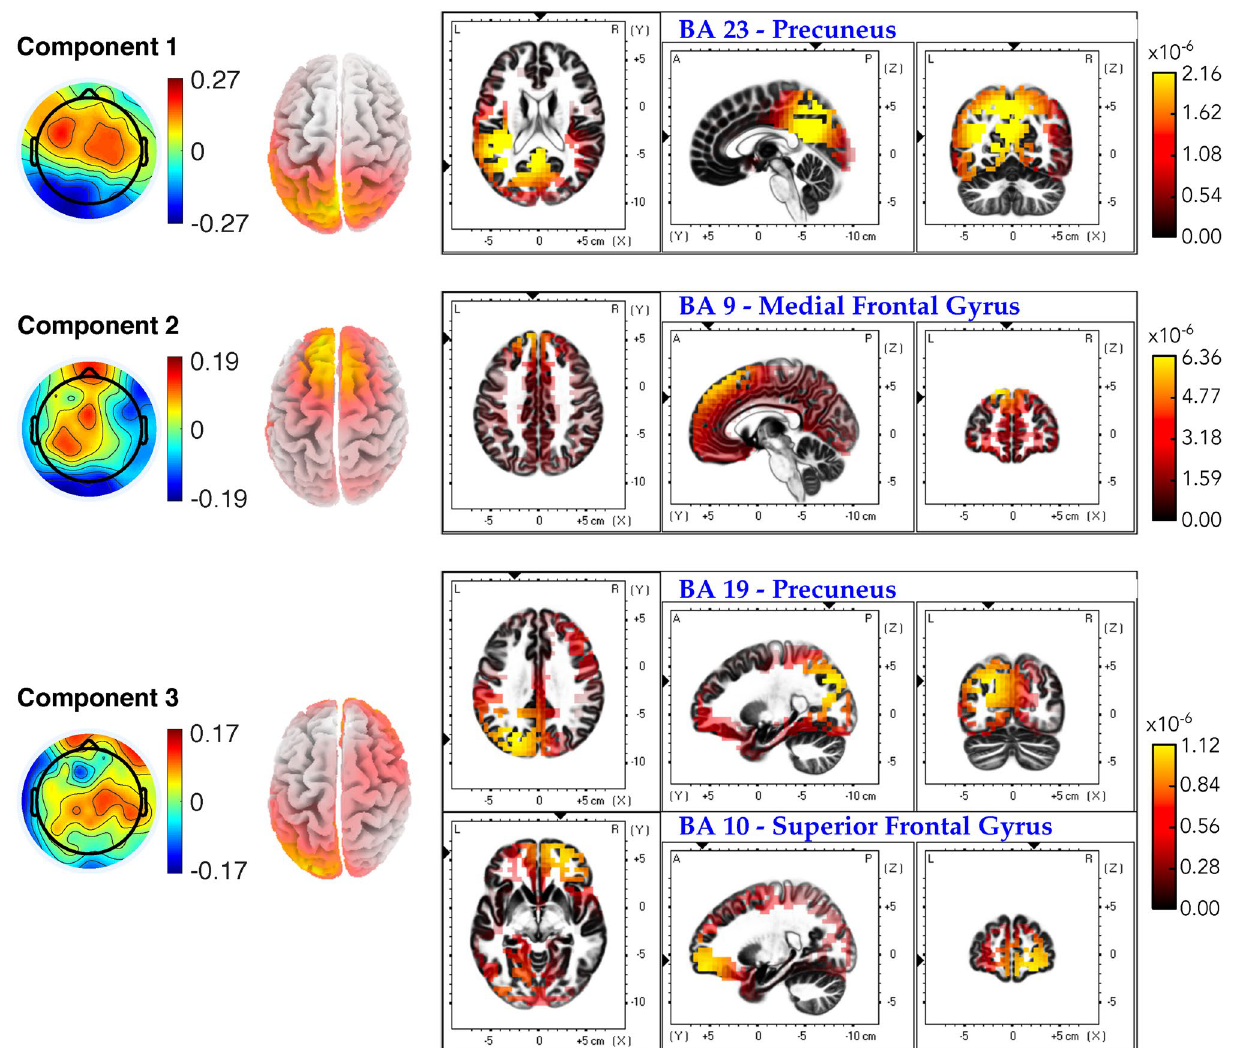
Figure 7. Neural source localization results for the first three ISC components. The scalp projections are shown in the leftmost column for respective components. The second column presents the estimated source distributions (top view). The remaining plots exhibit three orthogonal slices corresponding to the primary sources of the localization results. Full views of 3D source distributions for each component were depicted in Figure SC.1 of Supplementary Material